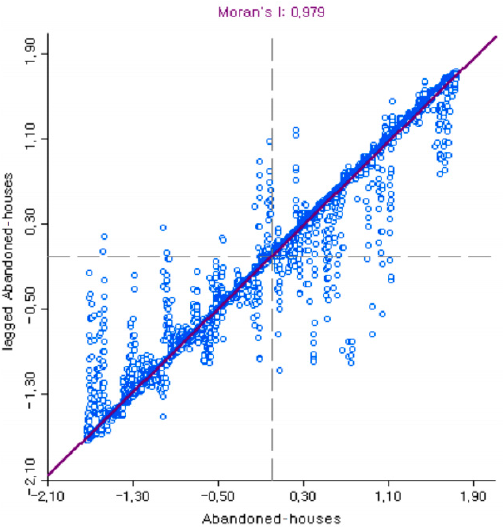
Table 3. Moran’s I test results.